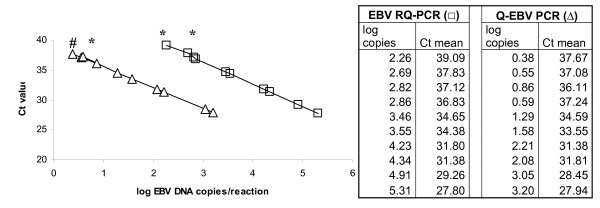
Correlation of EBV DNA load between EBV RQ-PCR (in-house assay: blank squares; R2: 0.999) quantification assay and Q-EBV PCR (commercial assay: blank triangles; R2: 0.999). The table lists Ct values and log copies. Copies were obtained by both real-time methods. Ct: Cycle threshold # = 1/3 replicates; * = 2/3 replicates.